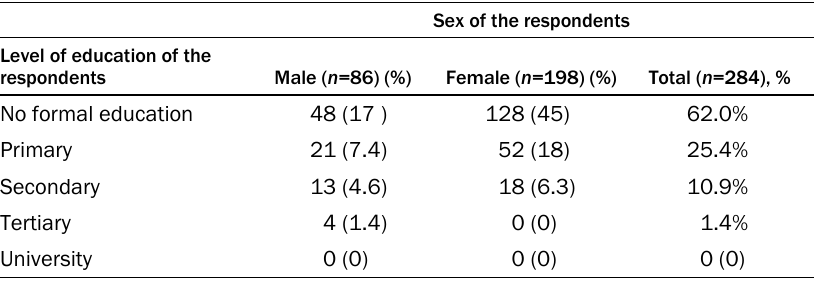
Table 1. Response Rate by Sex and Education of the Respondents Involved in a Camel Milk Value Chain Sex of the respondents